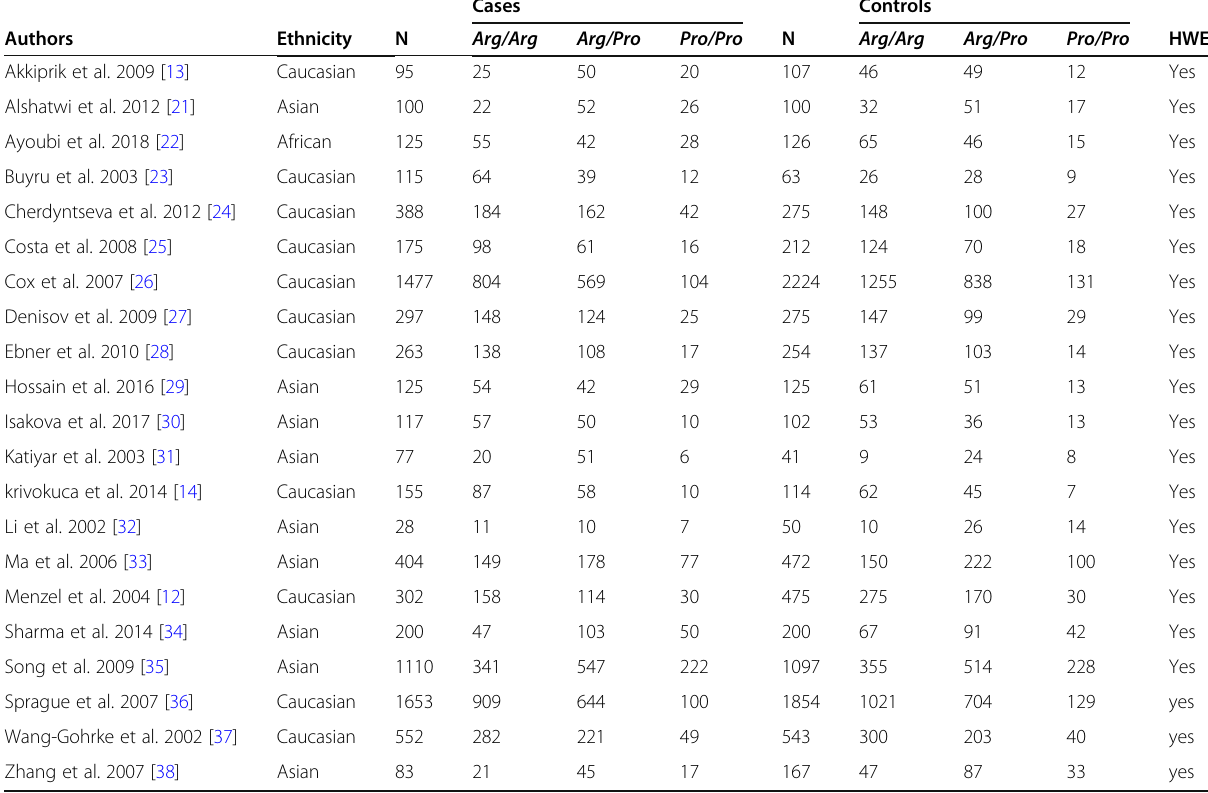
Table 1 Genotypes distribution of TP53 p.Arg72Pro in breast cancer cases and controls